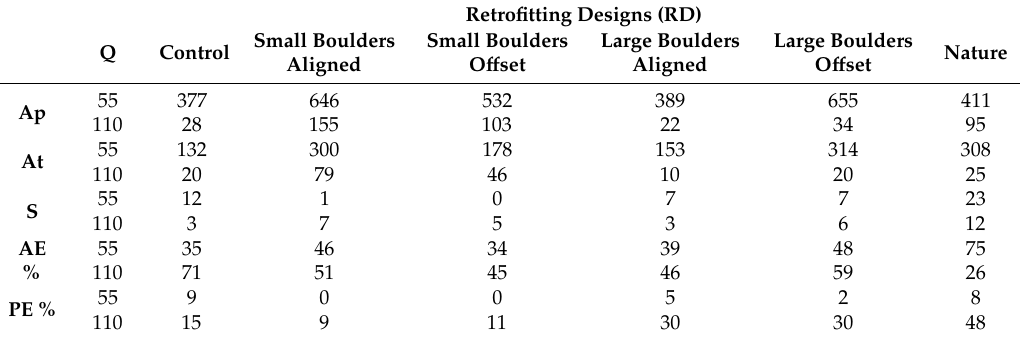
Table 1. Total number of attempts (At), approaches (Ap), upstream successful passages (S), as well as attraction e ffi ciency (AE%; ratio of the number of attempts per number of approaches × 100) and passage e ffi ciency (PE%; ratio of successful upstream passages per number of attempts × 100) for the control low-head ramped weir and the retrofitting designs (RD) selected, considering the